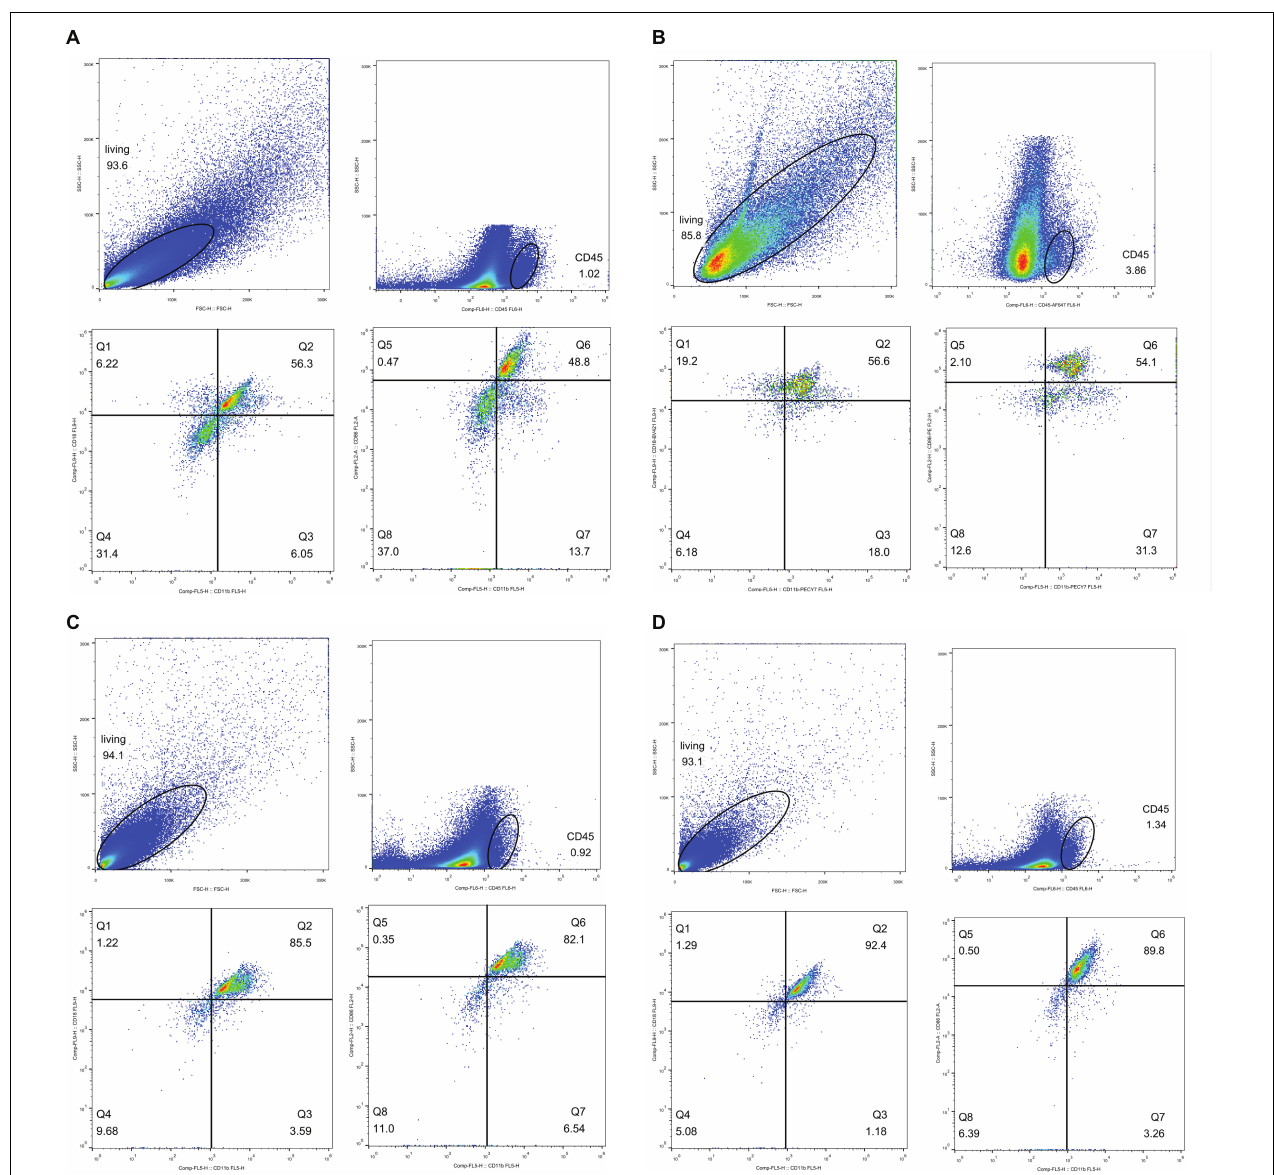
FIGURE 13 | Flow cytometry analysis. Neutrophil, CD45 + CD11b/c + CD18 + ; M1 macropahge, CD45 + CD11b/c + CD86 + . Gate setting: living cells → CD45 + → CD11b/c + → CD18 + or CD86 + . (A) Neutrophil, normal rat, Q2: CD45 + CD11b/c + CD18 + , accounting for 56.3%. M1 macrophage, normal rat, Q6: CD45 + CD11b/c + CD86 + , accounting for 48.8%. (B) Neutrophil, normal rat with contrast medium, Q2: CD45 + CD11b/c + CD18 + accounting for 56.6%. M1 macrophage, normal rat with contrast medium, Q6: CD45 + CD11b/c + CD86 + accounting for 54.1%. (C) Neutrophil, diabetes rats, Q2: CD45 + CD11b/c + CD18 + , accounting for 85.5%. M1 macrophage, diabetes rats, Q6: CD45 + CD11b/c + CD86 + , accounting for 82.1%. (D) Neutrophil, diabetes rats with contrast medium, Q2: CD45 + CD11b/c + CD18 + , accounting for 92.4%. M1 macrophage, diabetes rat with contrast medium, Q6: CD45 + CD11b/c + CD86 + , accounting for